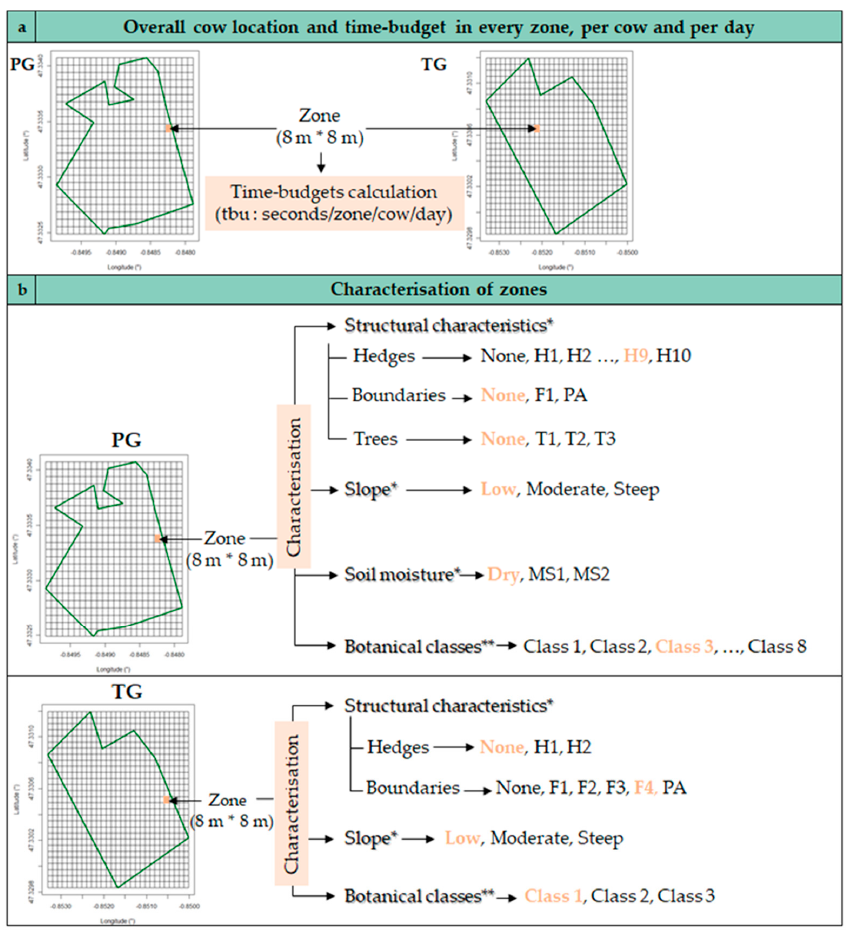
Figure 4. Time-budget computation in every zone, per cow and per day ( a ) and the characterization of the zones given the structural characteristics, slope, soil moisture and botanical classes ( b ) in the permanent grassland (PG) and temporary grassland (TG). Note: the complete characterization of the example grid zone marked orange on the map is given in orange in the adjacent text; * refer to the description provided in Figure 2; ** refer to the botanical classes provided in Figure